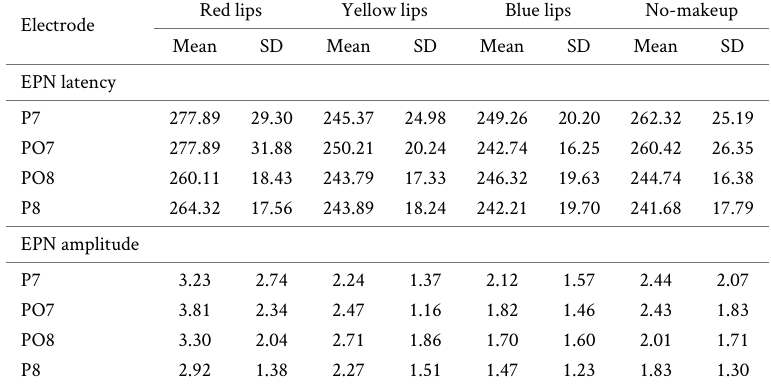
Table 4. Mean early posterior negativity (EPN) latency (ms) and amplitude ( µ V) for all conditions at four-electrode sites.